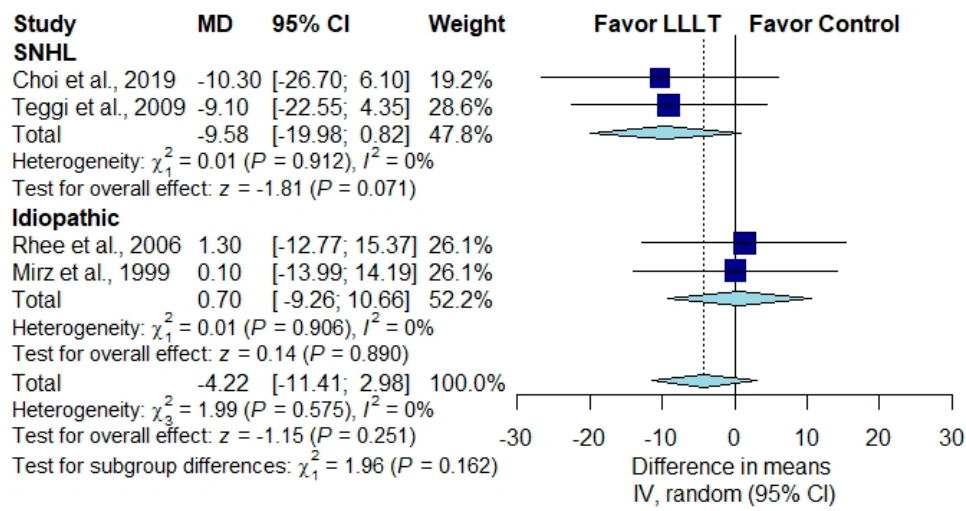
Figure 4. Subgroup analysis of THI scores in patients with SNHL and patients with idiopathic tinnitus [1,28,30,31].